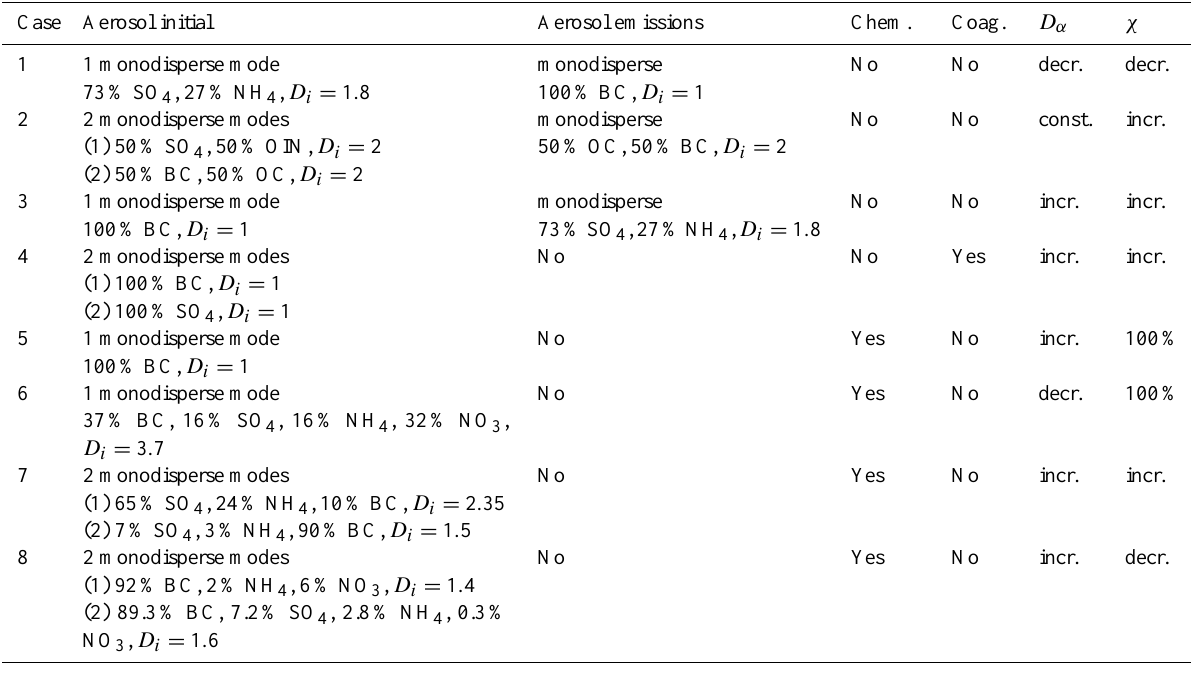
Table 6. List of single-process case studies. Column “Chem.” indicates if gas and aerosol phase chemistry were simulated, and column “Coag.” indicates if coagulation was simulated. Case Aerosol initial